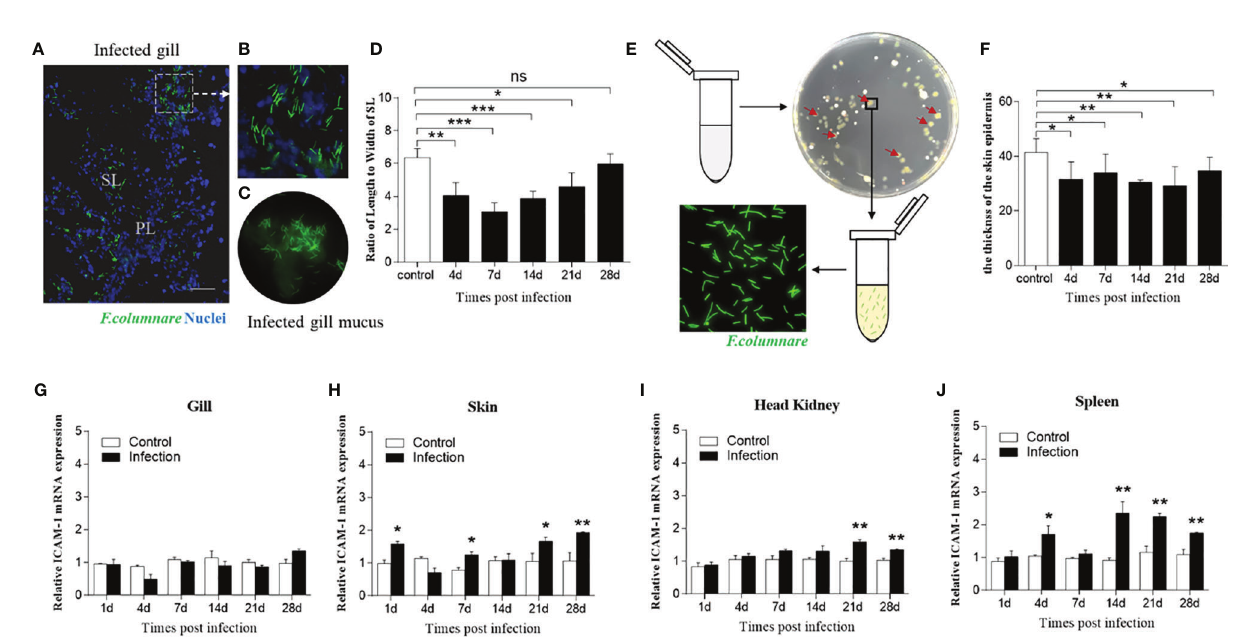
FIGURE 5 | Morphological and molecular differences after challenge with F. columnare . (A) Immuno fl uorescence staining of gills infected by F. columnare labeled with GFP (green fl uorescent protein). Green represents F. columnare ; blue indicates nuclei. SL, secondary lamellae; PL, primary lamellae. (B) Partial enlarged view of (A) . (C) F. columnare were detected in the infected gill mucus. (D) The length-width ratio of gill SL from fi sh uninfected and infected with F. columnare (n=6 per group). (E) F. columnare in the infected skin mucus propagated in the culture plate and monoclonal colony were selected to authenticate the present of F. columnare (green). (F) The thickness of skin epidermis at 4, 7, 14, 21, and 28 d post infection (n=6 per group). (G – J) ICAM-1 gene was modulated by F. columnare infection in the gills (G) , skin (H) , head kidney (I) , and spleen (J) at days 1, 4, 7, 14, 21, 28 post infection (n = 6 per group). Data are expressed as mean fold increase in expression. Statistical analysis was performed by unpaired Student ’ s t test. ns P > 0.05, *P < 0.05, **P < 0.01, ***P < 0.001 . Scale bar, 40 m m. Data are representative of three independent experiments (mean ±